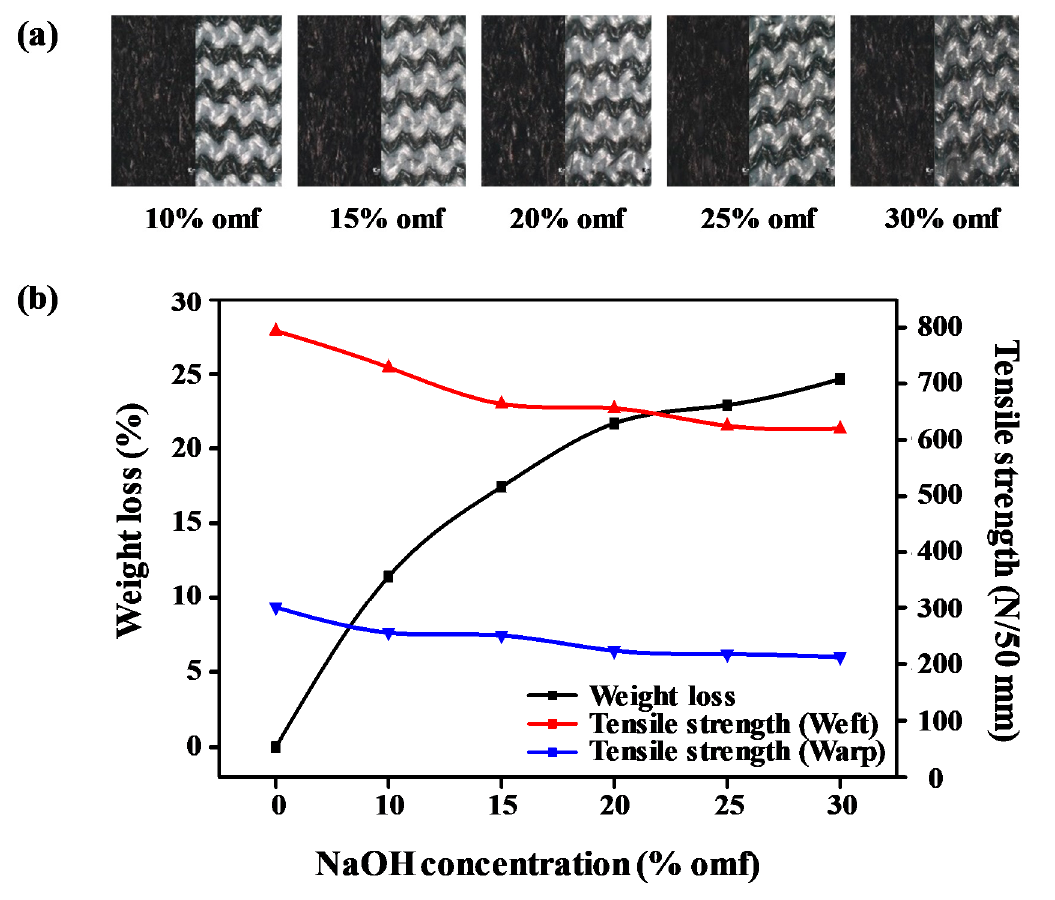
Figure 2. ( a ) Sea-island-type PET tricot fabrics treated at various NaOH concentrations (10–30% omf). Figure 2. ( a ) Sea ‐ island ‐ type PET tricot fabrics treated at various NaOH concentrations (10%–30% ( b ) Weight loss ratios and tensile strengths of sea-island-type PET tricot fabrics treated at various NaOH omf). ( b ) Weight loss ratios and tensile strengths of sea ‐ island ‐ type PET tricot fabrics treated at concentrations (10–30% omf). Table 1. Tensile strength retention of sea-island-type ultramicrofiber tricot fabrics treated with various NaOH concentrations at 100 ◦